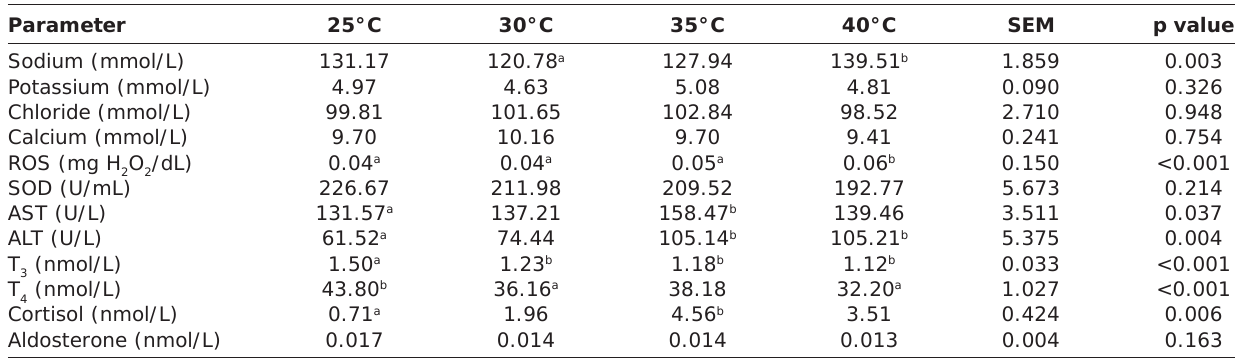
Table-2: Mean±SEM of different biochemical and endocrinal variants at 25°C, 30°C, 35°C, and 40°C in buffaloes.